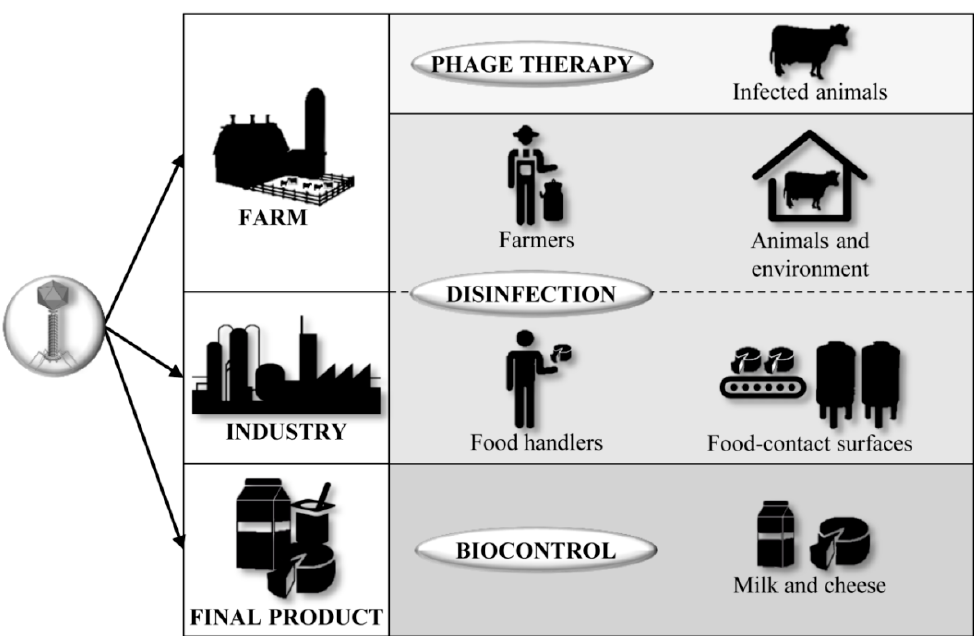
Figure 3. Principal points of disinfection and biocontrol along the dairy chain (from “farm to fork”), where phages can be applied to ensure dairy safety.